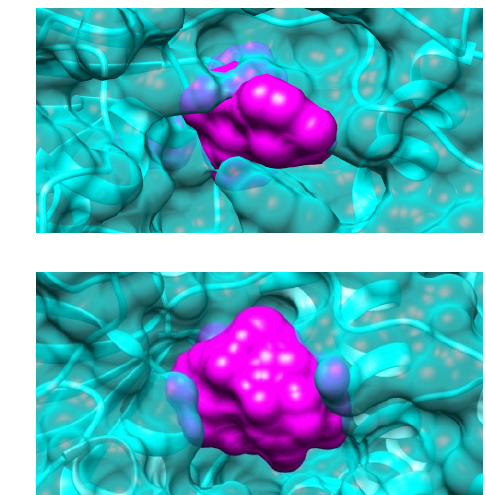
Figure 6. Structural conformation of the predicted active site of Eh HAPp49. Surface representation of the substrate-binding pocket of ( A ) Eh HAPp49 and ( B ) Ec AppA (PDB Entry 1DKP). Colored sur- faces: polypeptide chain (cyan) and pocket volume